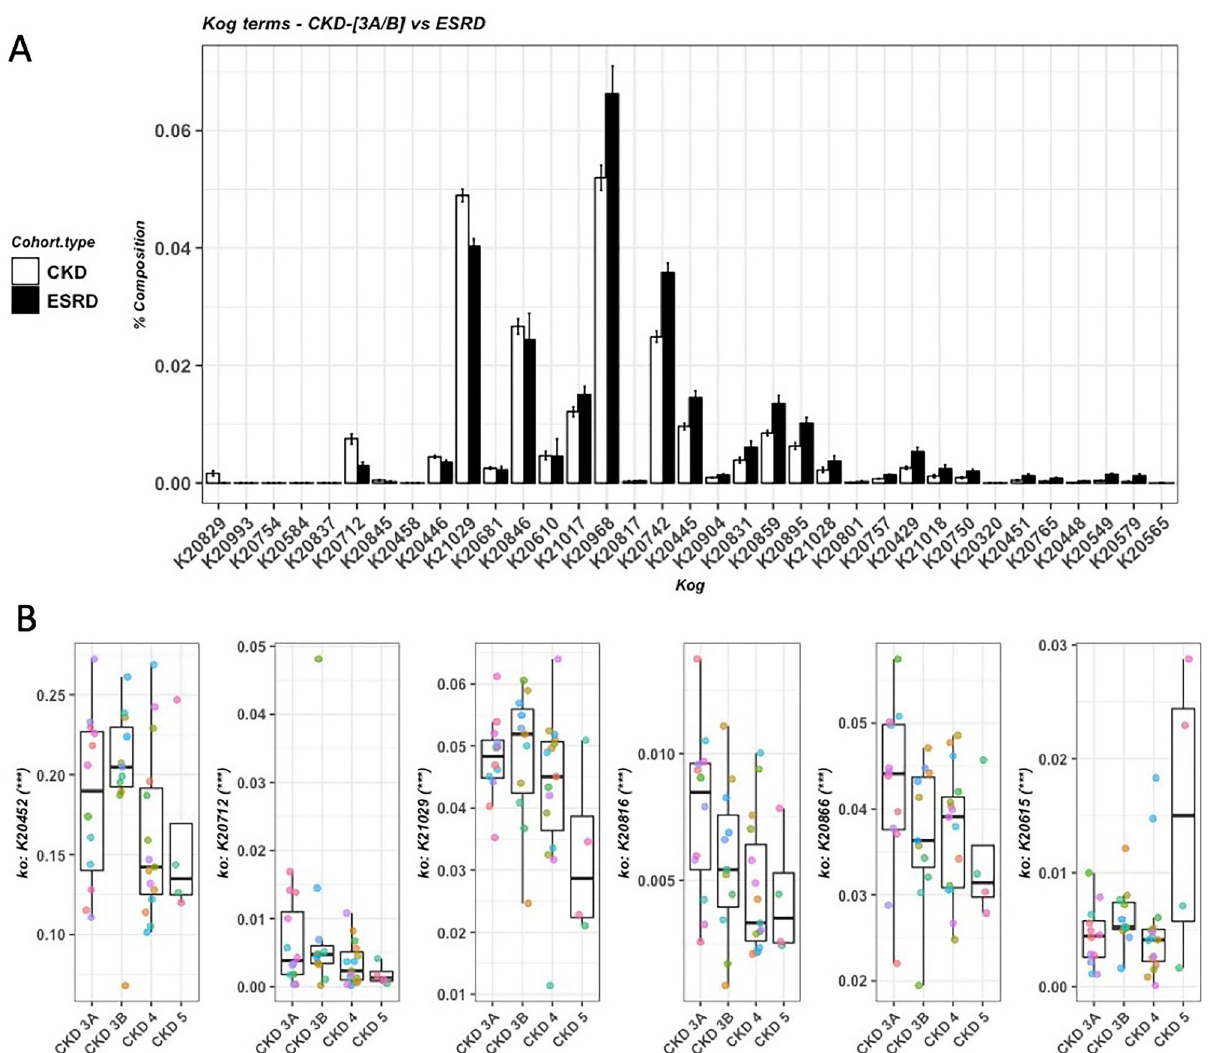
Figure 6. KOG enzymes. ( A ) Significant KOG enzymes between early stage CKD 3A/B (n = 23) and ESRD patients (n = 10). Wilcox-rank sum test was used to calculate p-values of top 100 KOG enzymes and multiple testing was corrected using FDR (FDR < 0.05 were shown). KOG definitions: Supplementary Table S5. ( B ) KOG families significantly associated with the severity of CKD (FDR < 0.05). Association was calculated by Maaslin2. K20712 3-(hydroxyamino)phenol mutase; K21029 molybdopterin-synthase adenylyltransferase; K20816 streptothricin hydrolase; K20615 capreomycidine synthase; K20866 glucose-1-phosphatase;